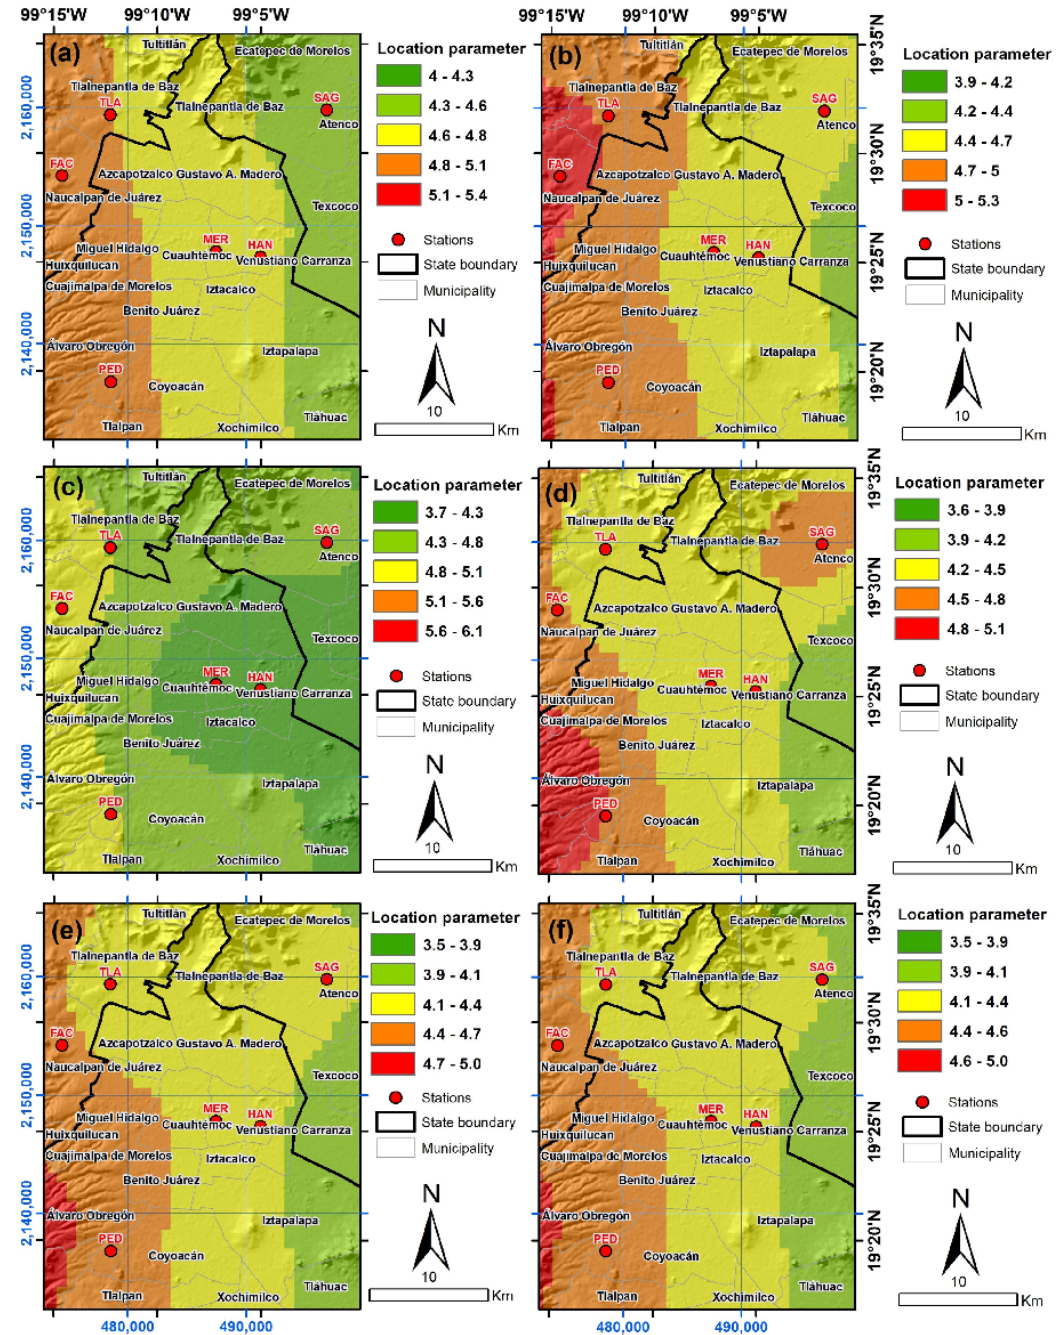
Figure 5. Estimated spatial smoothing of the location parameter for the years ( a ) 2000, ( b ) 2005, ( c ) 2010, ( d ) 2015, ( e ) 2018 and ( f )